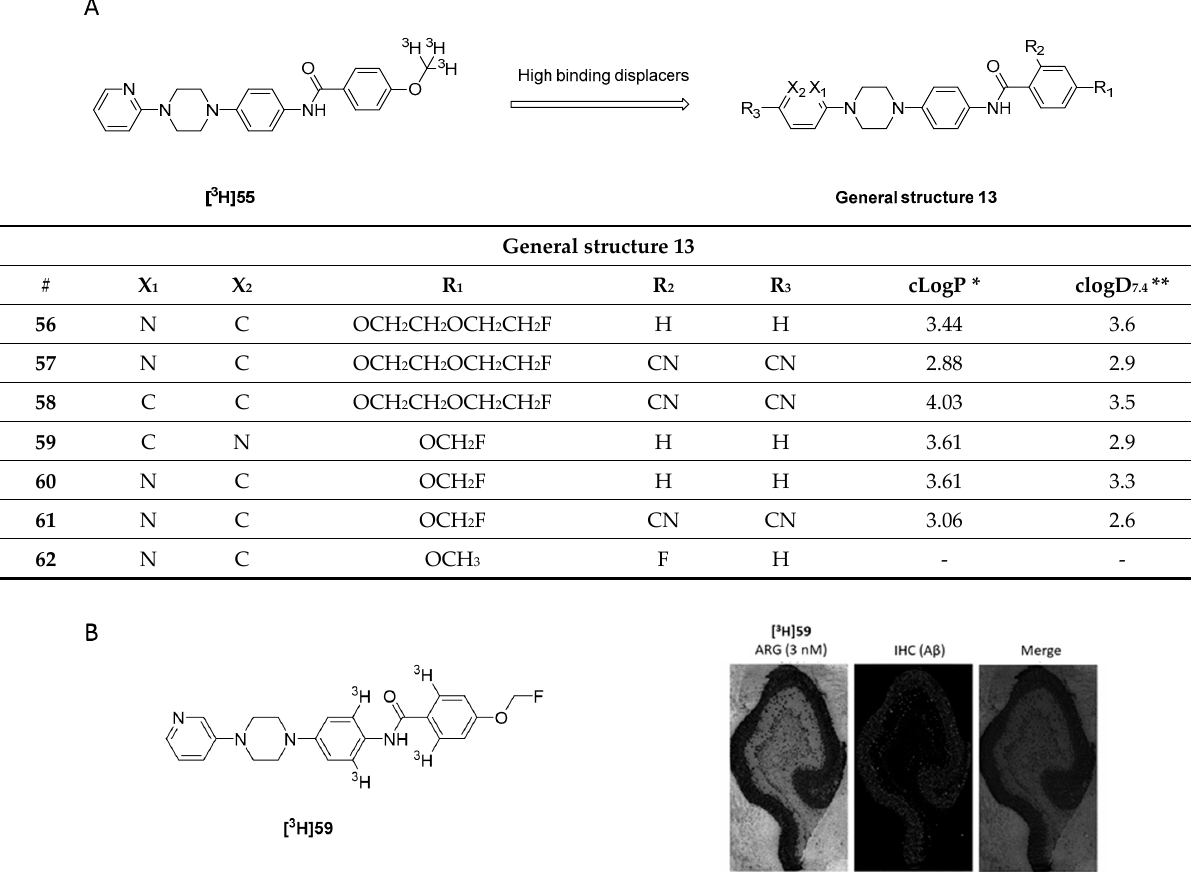
Figure 24. Chemical structures of N -phenylbenzamide analogues. ( A ) General structure of N -phenylbenzamide analogues (general structure 13) that showed to be high affinity displacers and chemical structure of [ 3 H]55 . Key properties are summarized in table below [136]. ( B ) Chemical structure of [ 3 H]59 and its binding to human AD brain tissue (cortical tissue) and comparison with staining of anti-A β mAb (adapted from Borroni et al. [136]). * clogP values were calculated by BioByte. ** clogD 7.4 values calculated by ACD/Percepta.